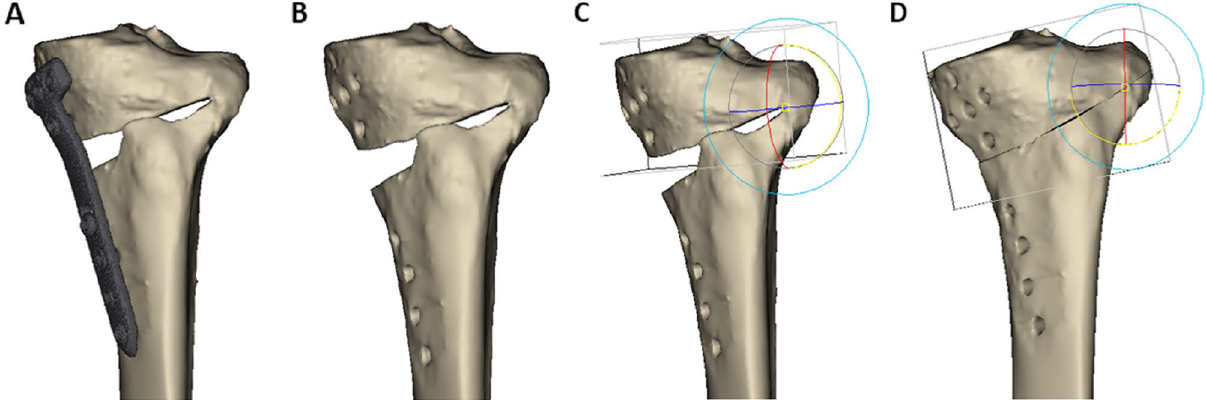
Figure 1. Steps to create a three-dimensional (3D) model of a pre-osteotomy original tibia. ( A ) reconstructed 3D model of tibia without soft tissue. ( B ) Virtual elimination of plate and screws from the 3D model ( C ) Rotation axis setting with the position about 1.0 cm before the lateral cortex and 1.5 cm below the articular surface as the hinge for restoration to pre-osteotomy original tibia. ( D ) Restoration to preoperative status of tibia by rotating the proximal segment around the rotation axis and eliminating the osteotomy gap. These figures were created using the Mimics software (version 17; Materialise, Leuven, in the posterior tibial slope and to quantitatively analyze how much the posterior tibial slope changes according to the degree of change in the osteotomy inclination angle, osteotomy with various inclination angles in the sagittal plane was performed on the restored 3D tibia model. To perform the virtual osteotomy, the tibial coordinate system was first determined by defining the x -, y -, and z- axes in the 3D model. The x - and y - axes were located on the joint plane of the tibia. To clarify the conditions for creating the joint plane of the tibia, 3 points were set on the surface of the tibial plateau according to the previous study 26 . The first point is on the most medial point of the medial tibial plateau, the second one is on the most posterior point of the medial tibial plateau, and the third one is on the most lateral point on the lateral tibial plateau. These 3 points made a joint plane of tibia (Fig. 2-A). The x -axis was defined as the line formed by each midpoint on the surface of the medial and lateral condyles of the tibia. To define the x -axis on the joint plane of the tibia, the midpoint of each plateau was established by the best-fit circle method 27 . Two circles that best fit the peripheral margin of medial and lateral plateaus were drawn on the joint plane. The centers of the best-fit circles were marked as the midpoint, and the line connecting the two midpoints was defined x -axis. The y -axis was determined as the vector perpendicular to the x -axis in the axial plane, and the z -axis was determined as the vector perpendicular to the x -axis in the coronal plane. After defining the x-, y-, and z-axes , the true lateral position of the 3D tibial model was obtained by manipulating the femur so that the medial and lateral condyles were overlapped in the sagittal plane 28 . At the same time, the y -axis was positioned horizontally and parallel to the ground, in accordance with a previous study 28 . To leave only the tibial model, the femur was virtually eliminated. Following this, the coronal plane of the 3D model was obtained by rotating the model by 90° around the z -axis. Second, three points were determined to set the osteotomy plane. In the coronal plane, point 1 (P1), the starting point of osteotomy, was placed on the anteromedial cortex of the proximal tibia, 3.5 cm below the medial end of the tibial plateau 25 . Point 2 (P2), which was used as a hinge, was located 1.0 cm medially from the lateral cortex of the tibia on the x -axis, 1.5 cm below the articular surface on the z -axis (Fig. 2-B) 24,25,29 , and at the midpoint of the entire length of the anteroposterior articular surface on the y -axis (Fig. 2-C). In addition to P1, as one of the two guide points for initiating the osteotomy, point 3 (P3) was placed on the posteromedial tibial cortex in the sagittal plane. The line connecting P1 and P3 was defined as the sagittal osteotomy line (Fig. 2-D). The angle between the line formed by P1 and P3 and the line of the medial tibial plateau was defined as the osteotomy inclination angle in the sagittal plane. In order to obtain an osteotomy line parallel to the medial tibial plateau line in the sagittal plane, P3 was positioned such that the line formed by P1 and P3 was parallel to the medial tibial plateau line. By changing the position of P3, while P1 and P2 were fixed, the osteotomy inclination angle could be changed (Fig. 3). Third, osteotomy was performed virtually along the plane including P1, P2, and P3. The osteotomy gap was opened according to the correction angle applied to each patient at the time of the actual surgery as measured using the Miniaci method 30 . The osteotomy gap ratio between the anterior and posterior openings was set to 0.67, based on a previous study 21 . Various osteotomy inclination angles in the sagittal plane were applied to the 3D tibial model. The osteotomy inclination angle was changed from –30° to 30° at intervals of 5° by changing the position of P3 (Fig. 4). The angle value was classified as positive in case of an anteriorly inclined osteotomy, in which the anterior part of the osteotomy line was inclined distally compared with the line parallel to the medial tibial plateau line (Fig. 4-A). Conversely, the angle value was classified as negative in the case of posteriorly inclined osteotomy, in which the anterior part of the osteotomy line was inclined proximally (Fig. 4-B). To make an anteriorly or posteriorly inclined osteotomy, P3 was set proximal or distal to the line passing through P1 while passing parallel to the medial plateau line. A total of 13 osteotomies were performed for each 3D tibial model at intervals of 5° for inclination angle from –30° to 30°. Measurement of the posterior tibial slope with 3D tibial model. The posterior tibial slope was measured on the 3D tibial model. In a true lateral position 28 , the image of the 3D tibial model was captured and measurement of the posterior tibial slope was conducted as presented in a previous study 23 . The posterior tibial